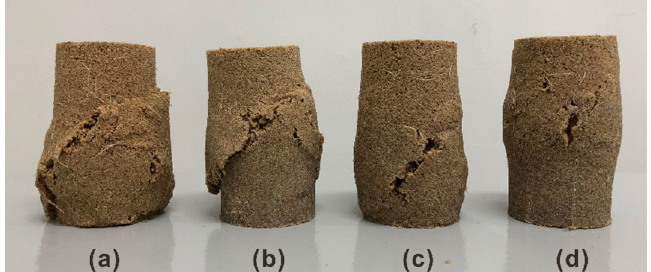
Figure 8. Variation of the failure characteristics of specimens treated with different PU content. ( a ) 0.6% fiber–1% polymer; ( b ) 0.6% fiber–2% polymer; ( c ) 0.6% fiber–3% polymer; and ( d ) 0.6% fiber–4%